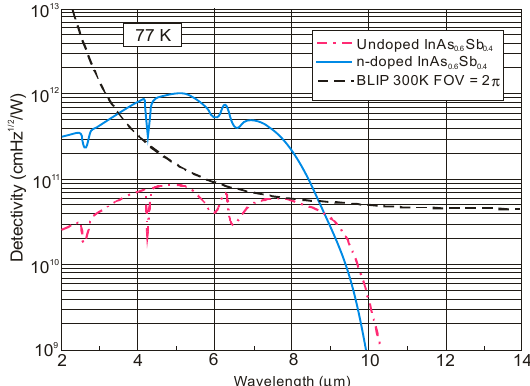
Figure 51. Spectral detectivity of barrier detectors with 1 µ m thick InAs 0.6 Sb 0.4 absorbers at T = 77 K. Dashed and solid lines represent devices with undoped and n-type doped absorbers, respectively. Dotted line shows the 300 K BLIP limit for a 2 π FOV (after [42 ] ).